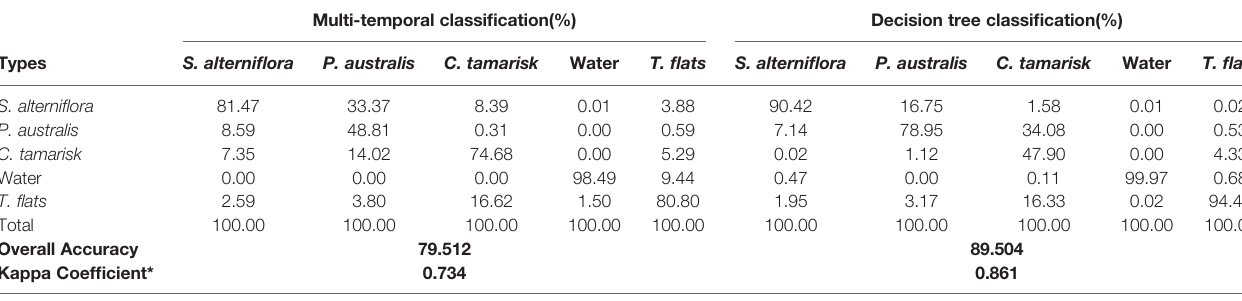
TABLE 2 | The confusion matrix of multi-temporal classi fi cation and decision tree classi fi cation. Multi-temporal classi fi cation(%) Decision tree classi fi